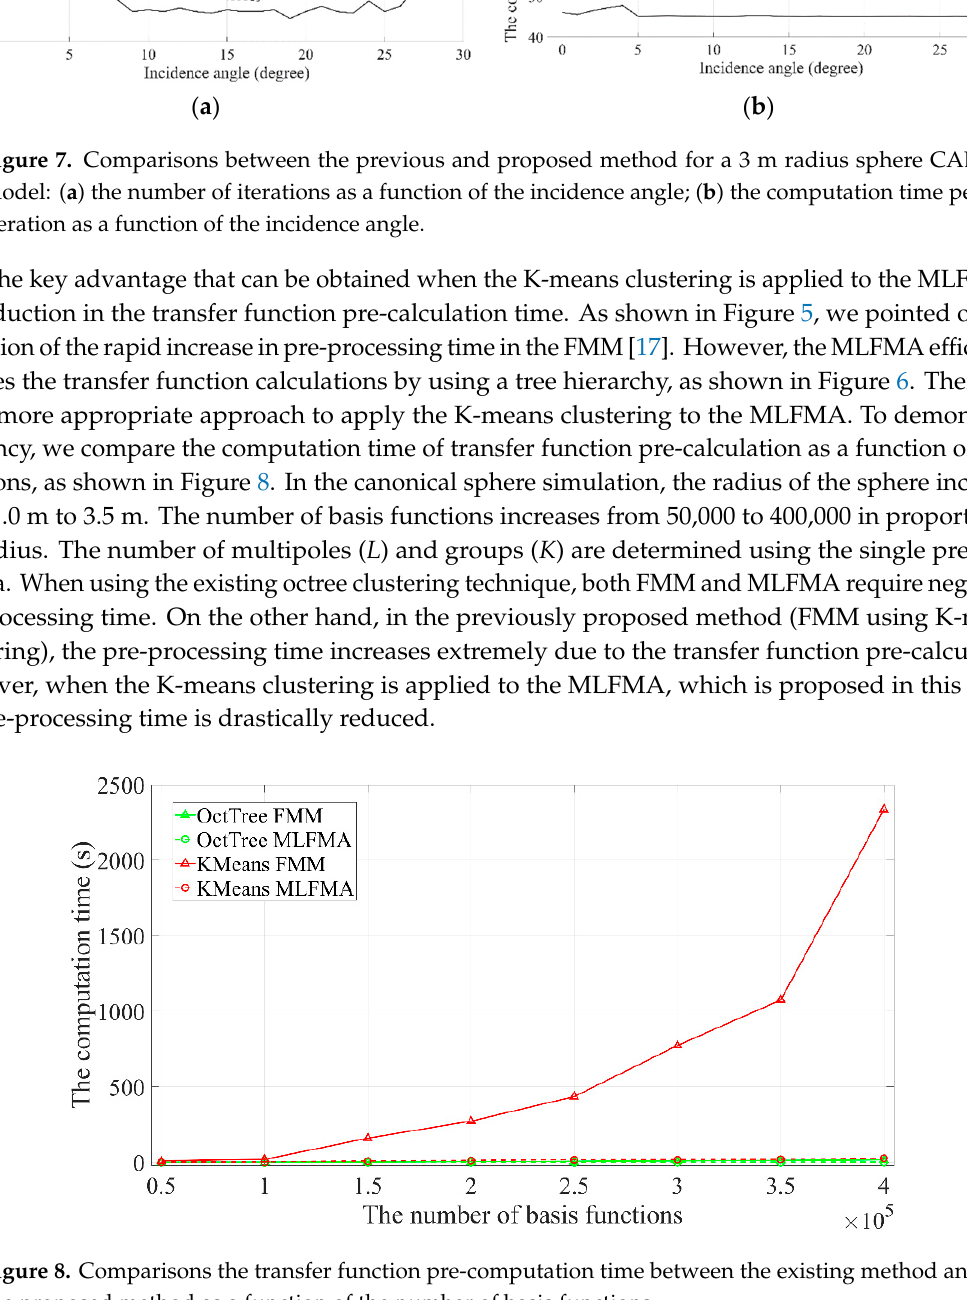
( b ) Figure 9. Canonical sphere CAD model simulation results: ( a ) the number of iterations as a function of the number of basis functions; ( b ) the computation time per iteration as a function of the number of basis functions. One should not ignore the comparison of the computational time required for pre-processing. We compare the computation time required for the three main pre-processing: clustering, near and far group separation, and transfer function calculation, as shown in Figure 10. Based on the results, the increase in computation time accompanying the proposed method is analyzed. Because the clustering is performed in a regular grid, overall pre-processing time is generally small in the conventional MLFMA. On the other hand, in the case of the proposed method requiring iterative